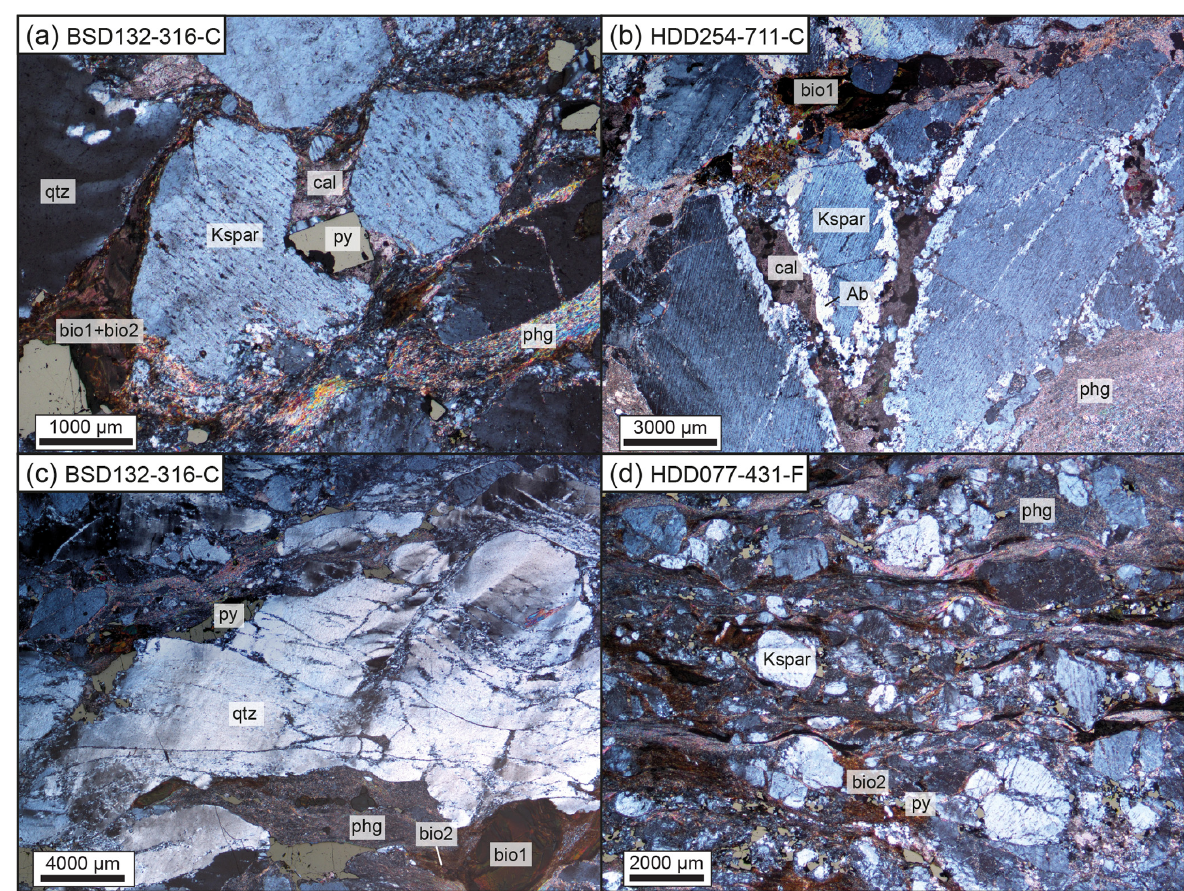
Figure 2. Dual transmitted and reflected light, cross-polarized photomicrographs showing the characteristic low-strain (a–c) and high-strain (d) microstructures and mineral relationships of studied samples. (a) Sample BSD132-316-C shows fractured perthitic feldspar (Kspar) from assemblage 1 in the center with calcite (cal), phengite (phg), pyrite (py) and quartz (qtz) from assemblage 2 filling the fracture. Quartz and biotite 1 (bio1) show the formation of sub-grains (biotite 2; bio2). (b) In sample HDD254-711-C, a carbonate (calcite) from assemblage 2 fills shear fractures that crosscut perthitic feldspar from assemblage 1. Reaction rims along fractures show the breakdown of perthite to albite (Ab). (c) Sample BSD132-316-C shows brittle–ductile deformation of large quartz and biotite 1 (bottom right) grains and precipitation of pyrite in strain shadows. (d) Sample HDD077-431-F shows porphyroclasts of perthitic feldspar within a mylonitic matrix consisting of biotite 2, quartz, carbonate, pyrite and